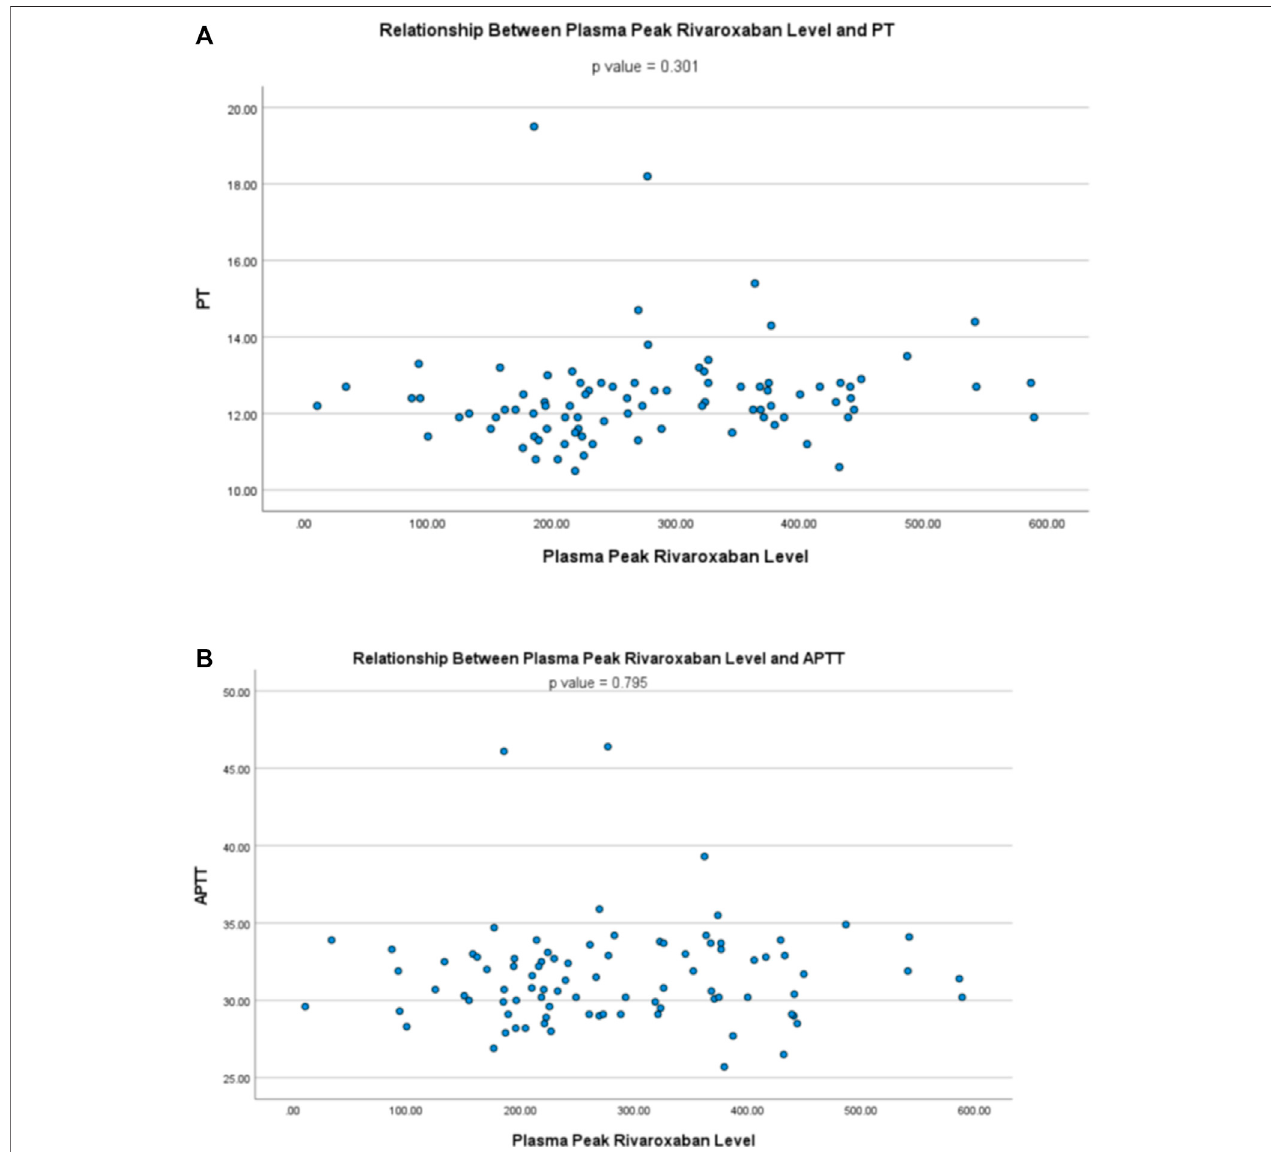
FIGURE 6 | Relationship between plasma peak rivaroxaban level and (A) prothrombin time (PT) and (B) activated partial thromboplastin time (APTT).